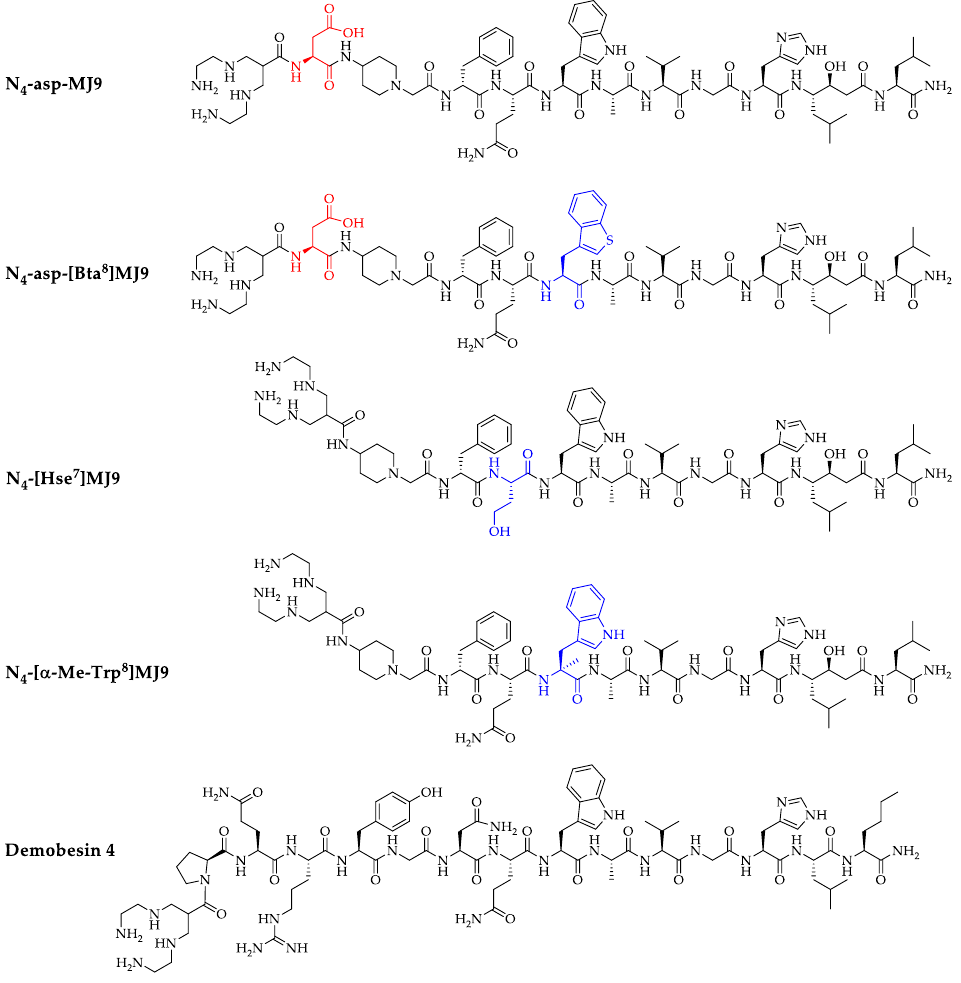
Figure 1. Chemical structures of N 4 -asp-MJ9, N 4 -asp-[Bta 8 ]MJ9, N 4 -[Hse 7 ]MJ9, N 4 - [α -Me-Trp 8 ]MJ9 and the reference ligand Demobesin 4. Pharmacophoric modifications are highlighted in blue, while linker section modifications are highlighted in red.